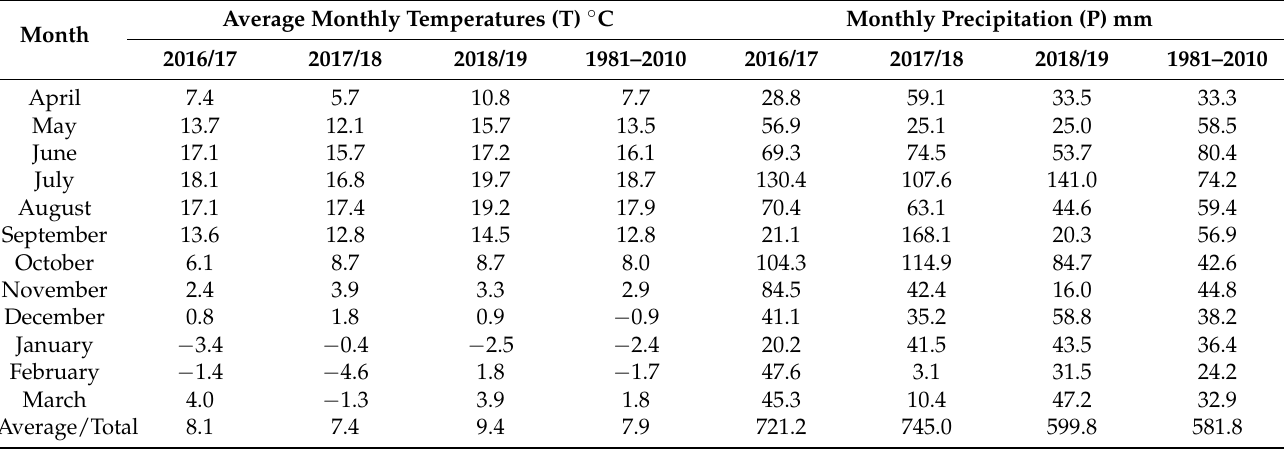
Table 2. Meteorological data during the